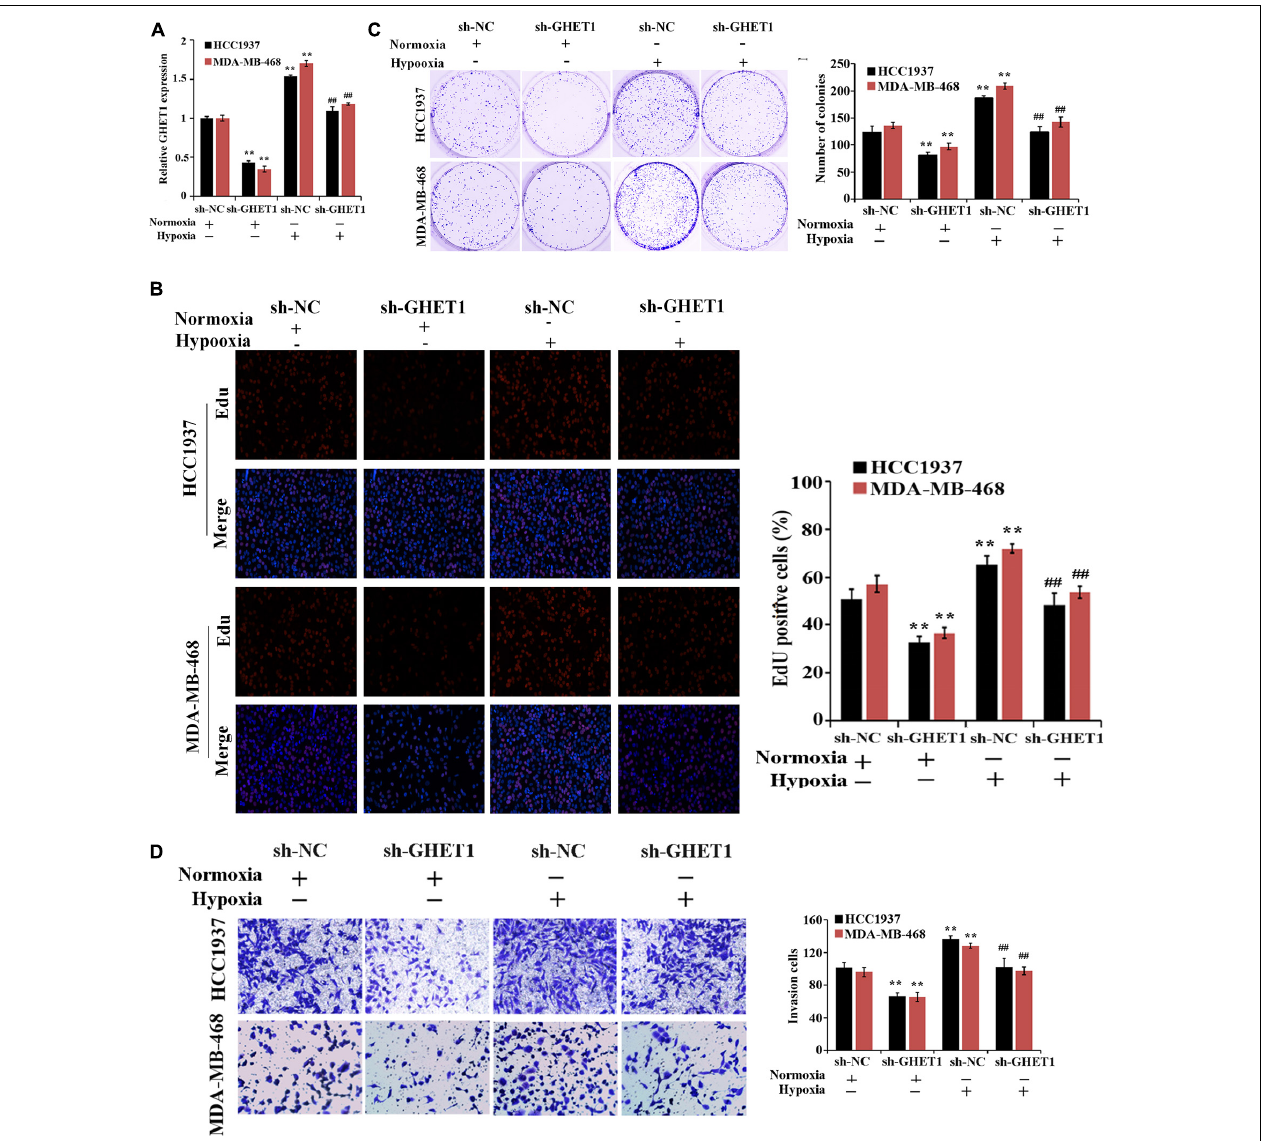
FIGURE 2 | Inhibition of hypoxia-induced proliferation and invasion of TNBC cells by downregulation of lncRNA GHET1. (A) qRT-PCR was performed to detect the expression of lncRNA GHET1 in MDA-MB-468 and HCC1937 cells under normoxia and hypoxia conditions. (B) EdU assay wad used to detect the cell proliferation. (C) Cell viability was analyzed by colony formation assay. (D) Transwell assay was used to detect cell invasion. ** P < 0.01 vs. Normoxia + sh-NC group; ## P < 0.01 vs. Hypoxia + sh-NC group.